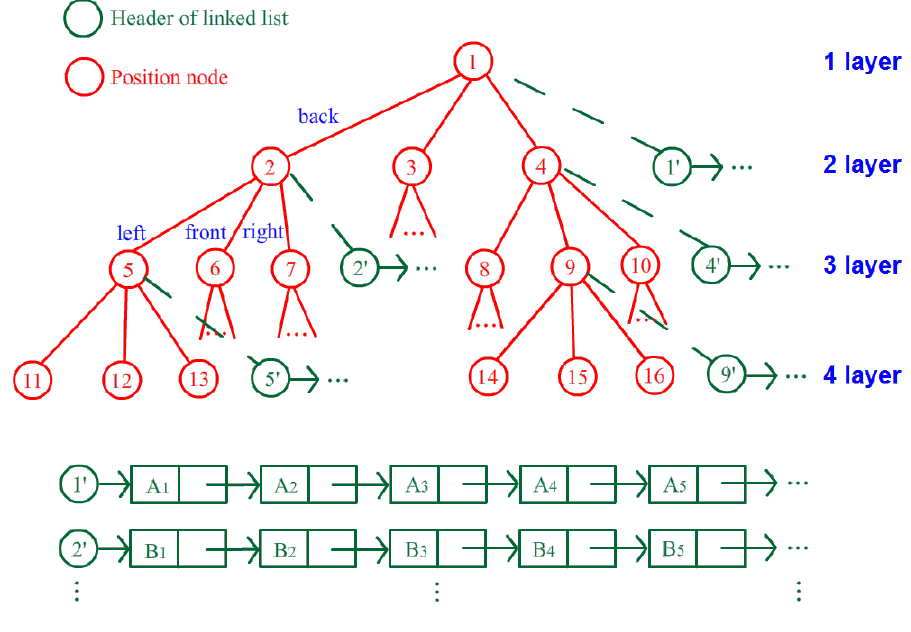
Figure 10. Illustration of the quadtree structure.